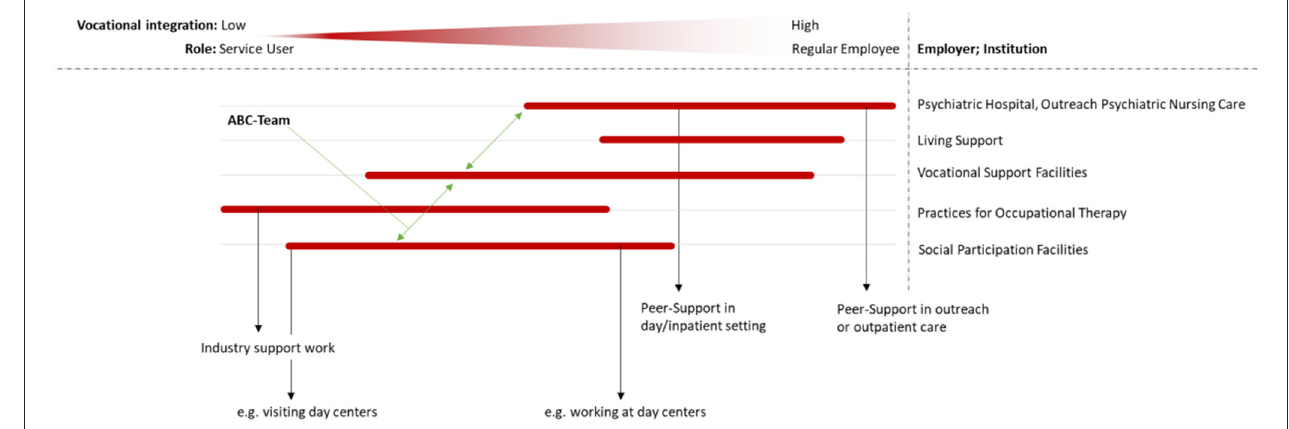
FIGURE 1 | The opportunities to participate in the fields of work and activities are shown as a gradient in relation to the implementation of work-related participation and the different roles (i.e., service user to employee, for example in the field of peer support). The ABC team makes a flexible change possible between workplaces and tasks, occupational support facilities are regulated by the underlying financial structure in each